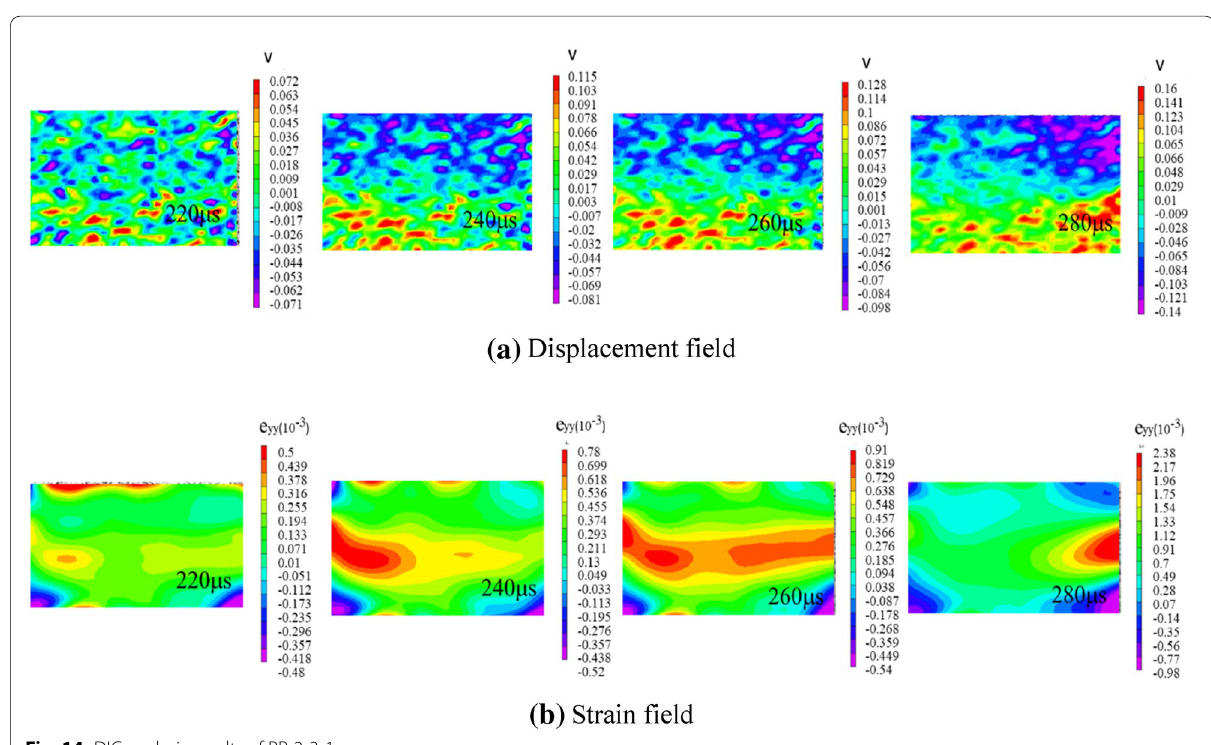
Fig. 14 DIC analysis results of